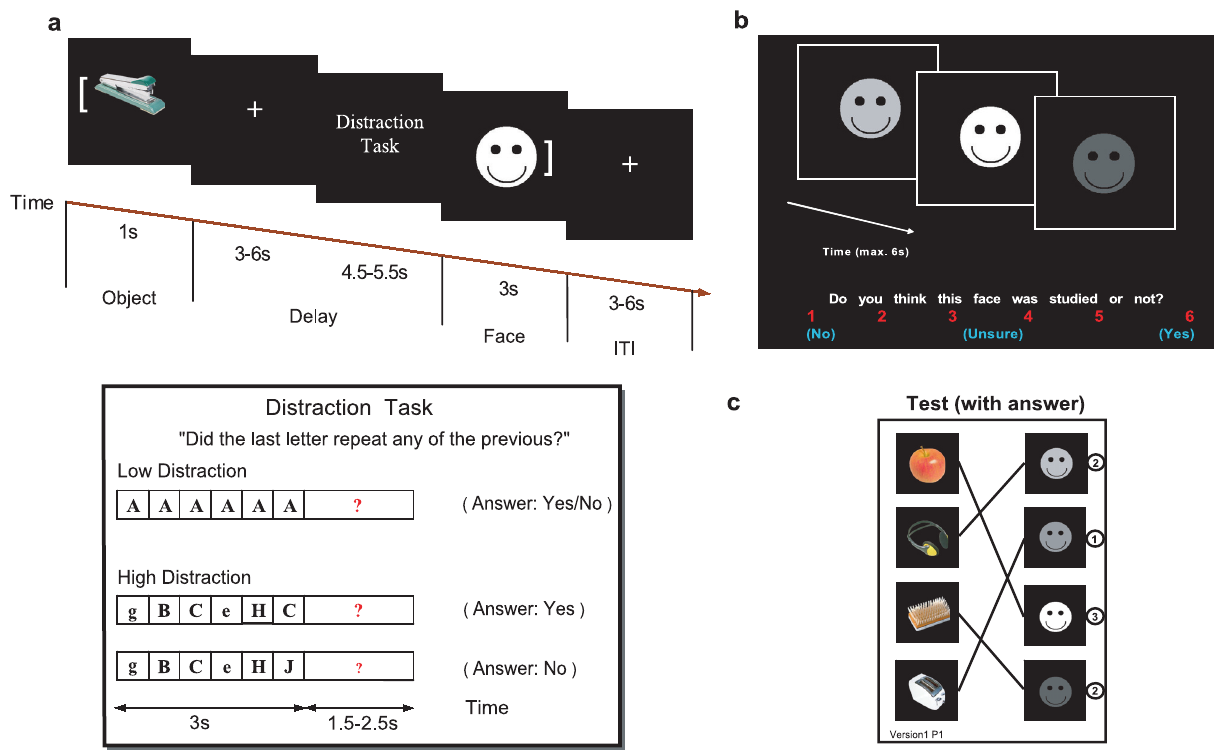
Figure 1. Experimental paradigm. Encoding task inside the scanner ( a ) and the post-scan memory tests ( b , c ). a , top , In each trial, the image of an object was presented first, followed by a fixation cross, the distraction task, and the face. a , bottom , The distraction task was either a simple visuo- motor control task (low distraction condition) or a working memory task (high distraction condition). In both tasks, six letters were sequentially presented and subjects had to indicate whether the final letter of each sequence was identical to one of the previous five letters. b , Face recognition memory test. Subjects had to make an old-new judgment on each sequentially presented face by a confidence rating on a six-point scale. c , The associative memory test. Subjects had to connect the studied object-face pairs by lines and add a confidence rating. Note: in this figure, the actual face stimuli are replaced by smiley, because of unclear copyright status.